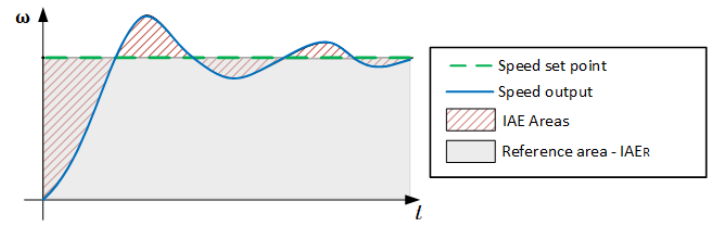
Figure 4. Composition of the integral of the absolute